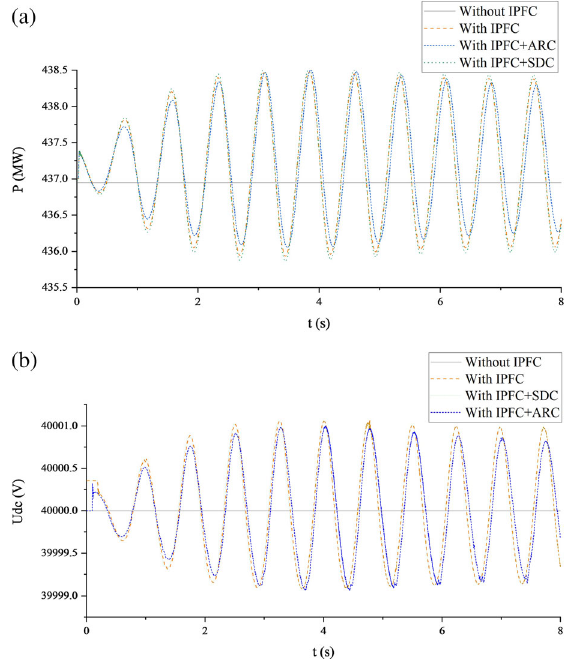
Fig. 10 Forced oscillation in the auxiliary control transmission line for three cases: without IPFC, with IPFC only, and IPFC based on ARC: a Simulation results of P jl ; b Simulation results of U